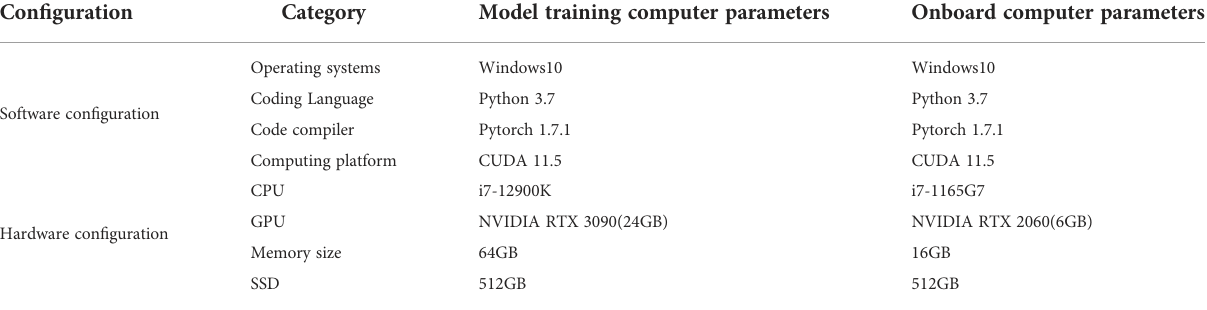
TABLE 1 Parameters of the experimental